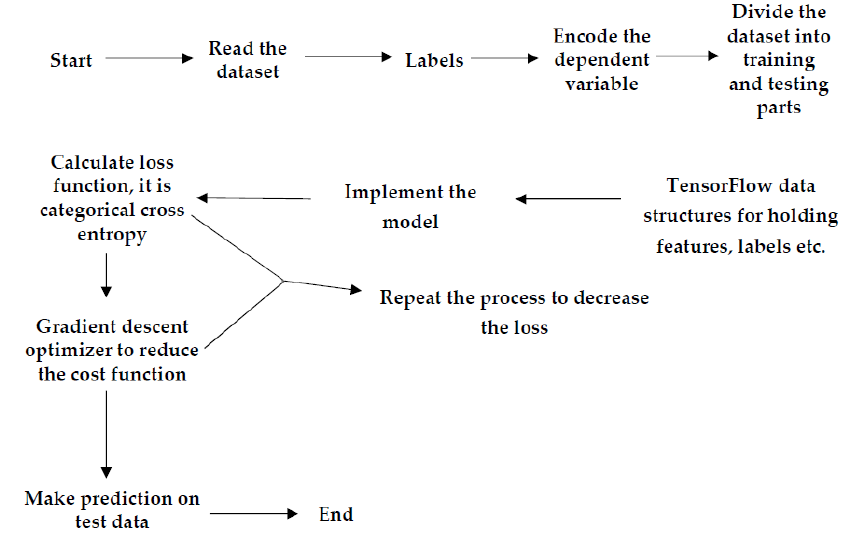
Figure 3. System process flowchart of Multilayer Perceptron (MLP) and Convolution NN. To define features and labels in the dataset, two TensorFlow variables were defined. One hot encoder was used to encode the dataset.